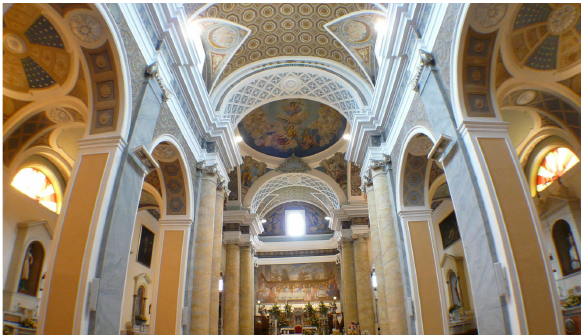
Figure 2. Baranello (Campobasso). Church of St. Michele Arcangelo: the main nave (Romano, 2016).